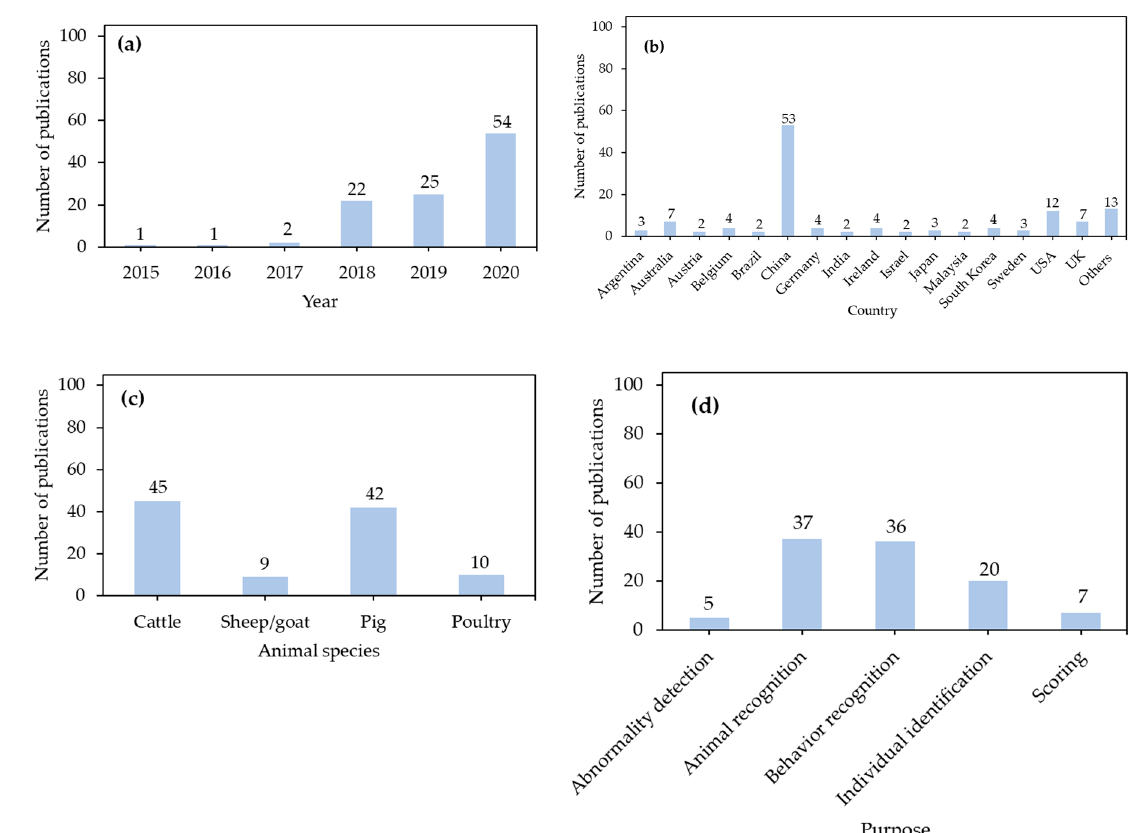
Figure 12. Number of publications based on ( a ) year, ( b ) country, ( c ) animal species, and ( d ) purpose. One publication can include multiple countries and animal species. “Others” are Algeria, Philippines, Nigeria, Italy, France, Turkey, New Zealand, Indonesia, Egypt, Spain, Norway, Saudi Arabia, and Switzerland.